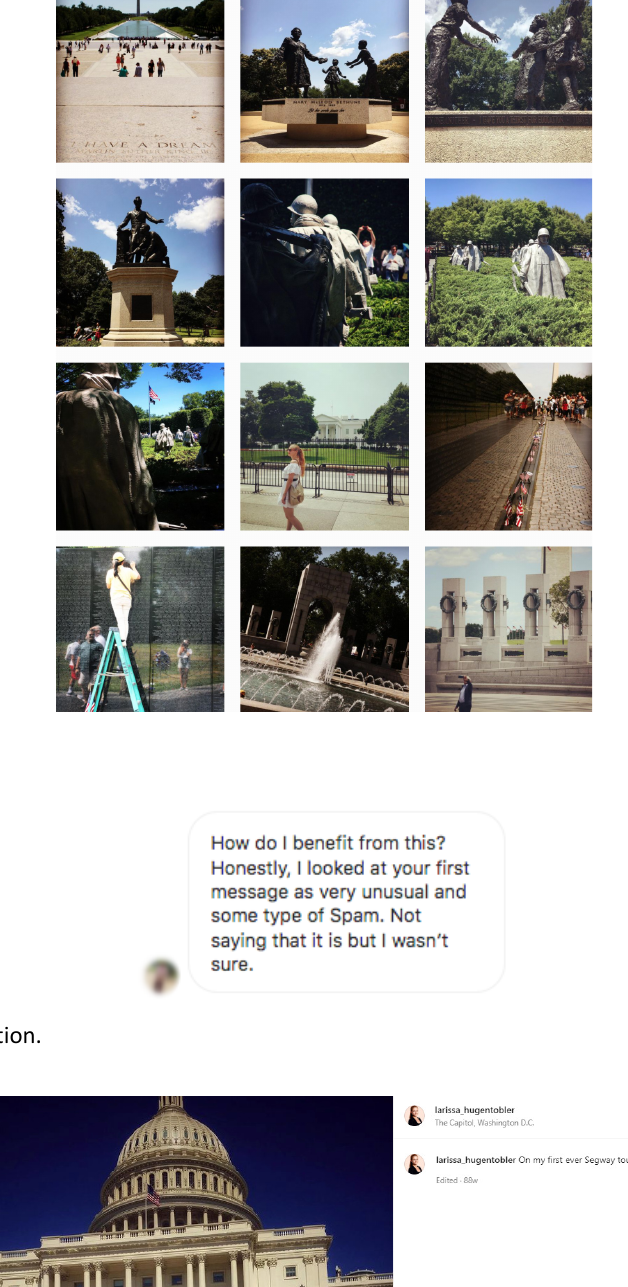
Figure 3. Interviewee hesitation.